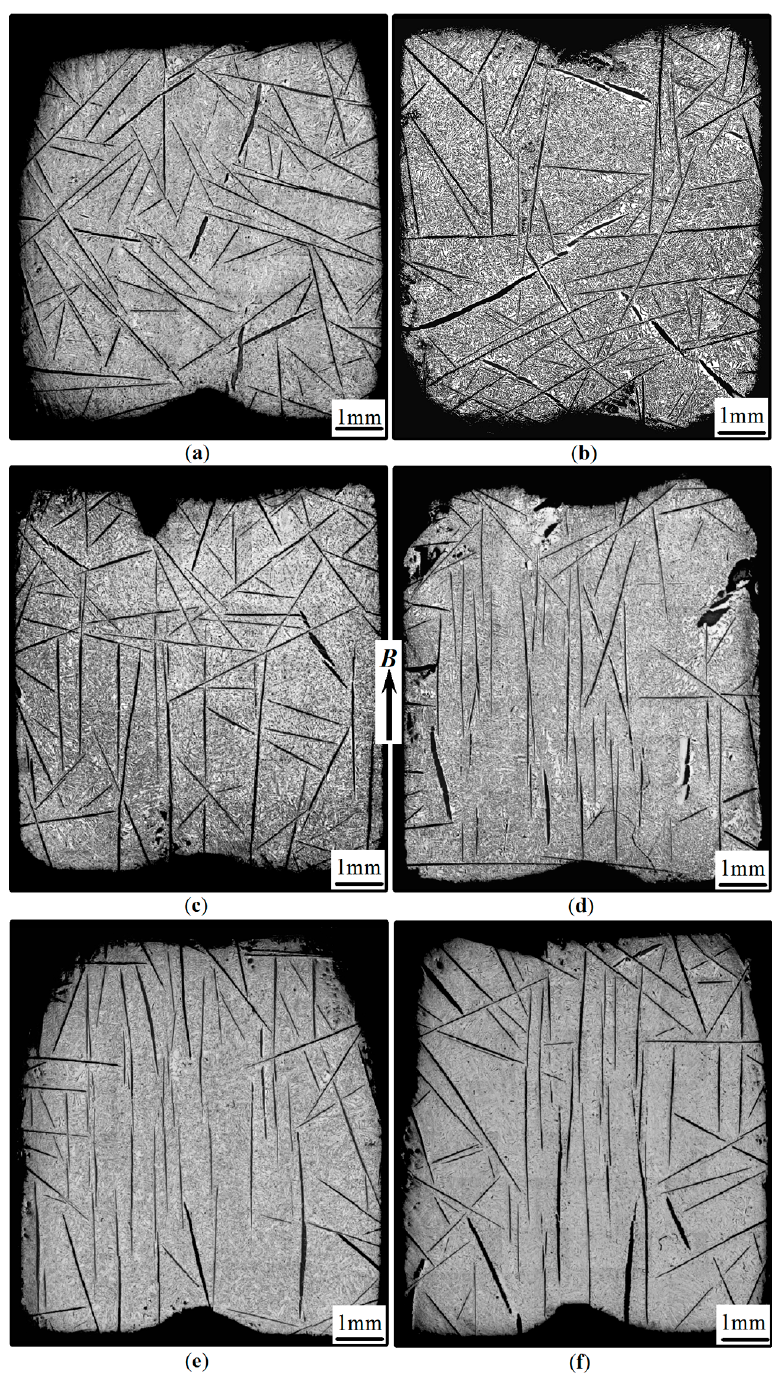
Figure 2. Longitudinal macrostructures of the Zn-Sn-Bi alloy under various magnetic fields: ( a ) 0 T; ( b ) 0.6 T; ( c ) 1.5 T; ( d ) 3 T; ( e ) 5 T; ( f ) 12 T. The arrow indicates the direction of B .